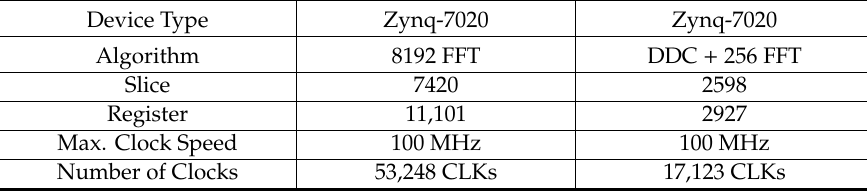
Table 1. FPGA synthesis result before and after applying DDC.